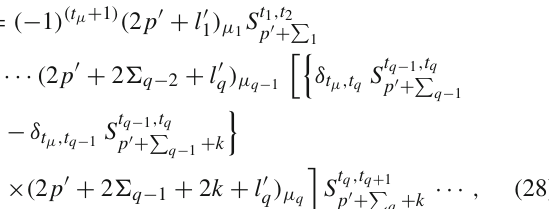
Fig. 6 Set of s diagrams showing all possible insertions of a virtual photon at vertex μ which is one of the already existing s vertices on the p (cid:6) leg of a scalar particle (dashed lines), thus giving rise to a 4-point